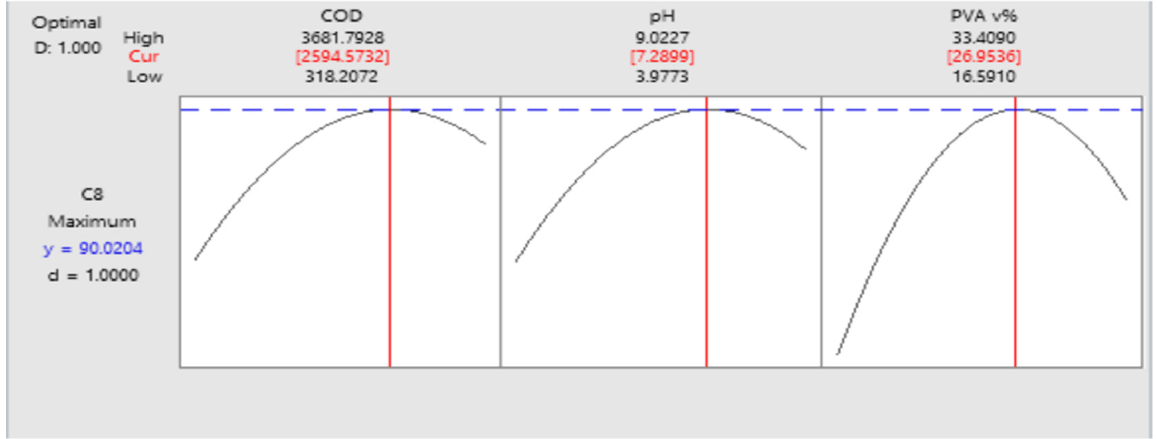
Figure 3. The optimum conditions for COD reduction% were obtained using the response optimizer.